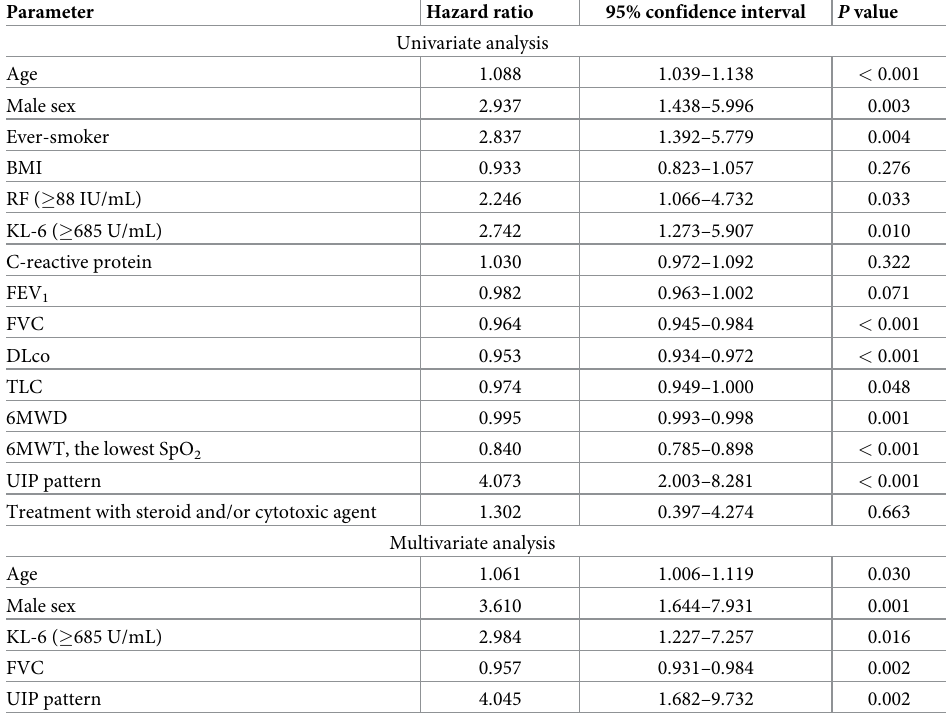
Table 4. Risk factors for the mortality in patients with RA-ILD assessed by Cox proportional hazards model.